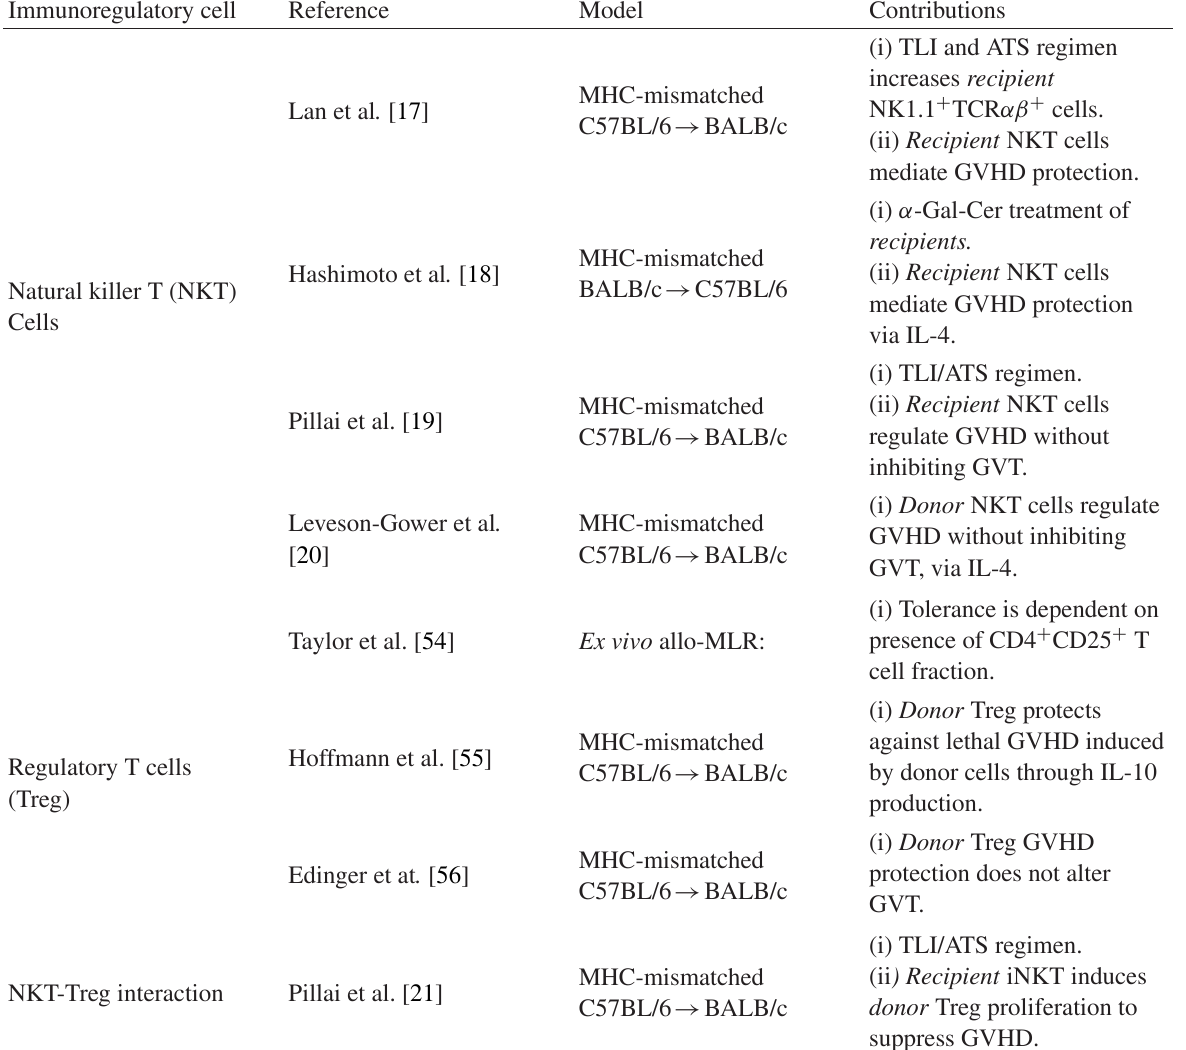
TABLE 1: Murine models of immunoregulatory cells in hematopoietic cell